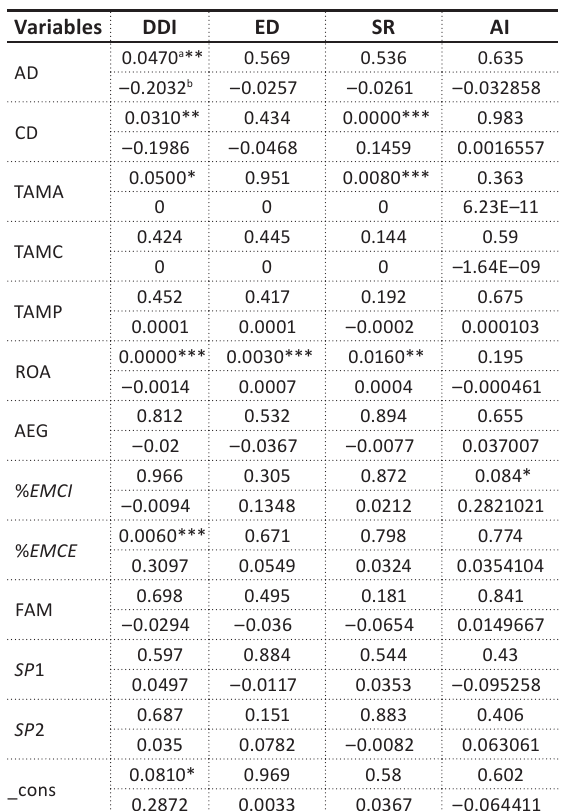
Table 9. Regression by simultaneous